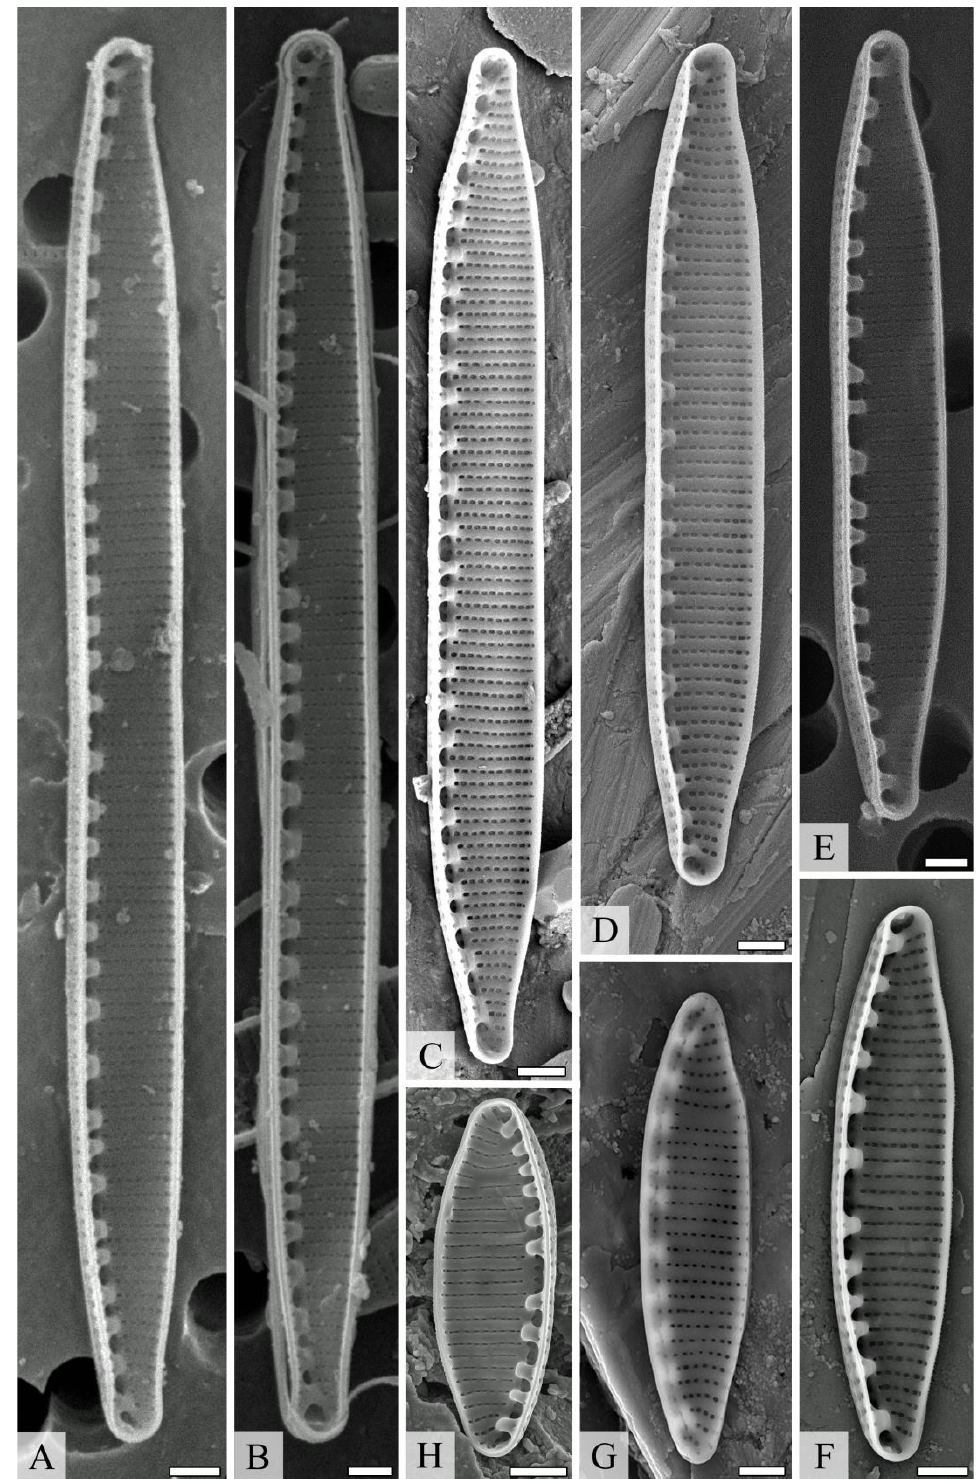
Figure 5. Valve morphology of the investigated N. acidoclinata clones. ( A – E ) linear – lanceolate valves with retracted capitate apices, ( F , G ) lanceolate valves with wedge-shaped apices, ( H ) elliptical – lanceolate valve with rounded apices. Scanning electron microscopy. Scale bars = 1 μm.